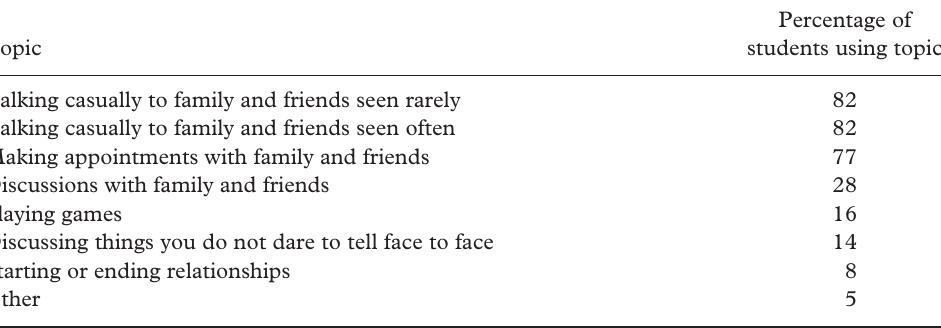
Table 2. IM conversation topics (excluding educational use) and Dutch higher